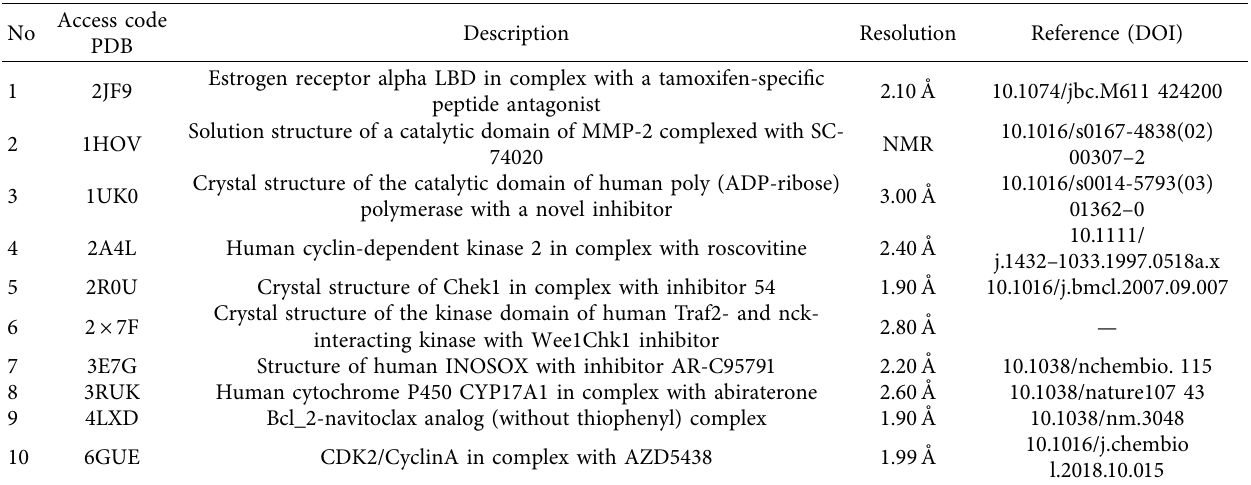
Table 1: Crystal structures were